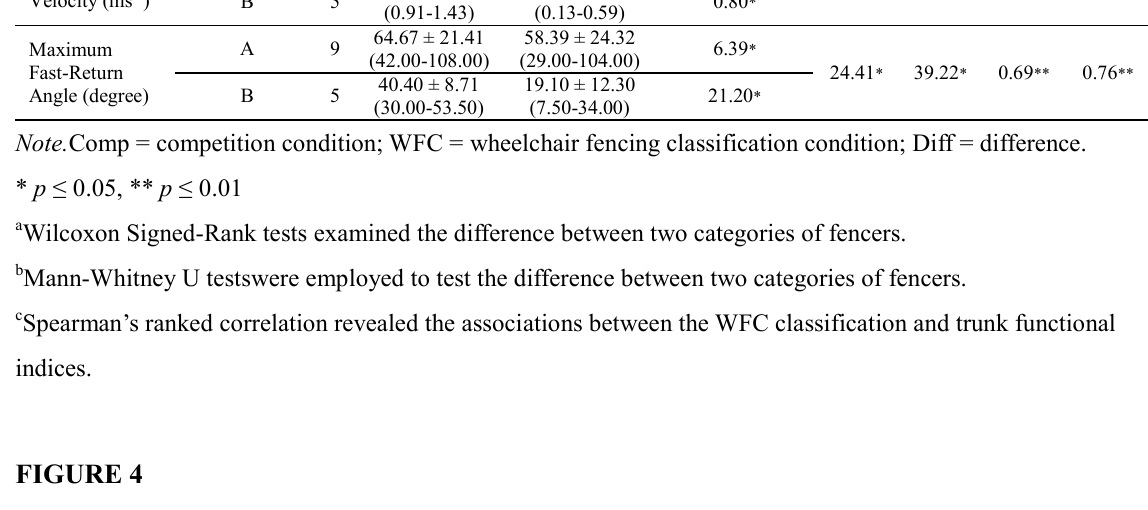
Computation of maximum trunk angle. SH represents the line between the shoulder of the fencing arm and the